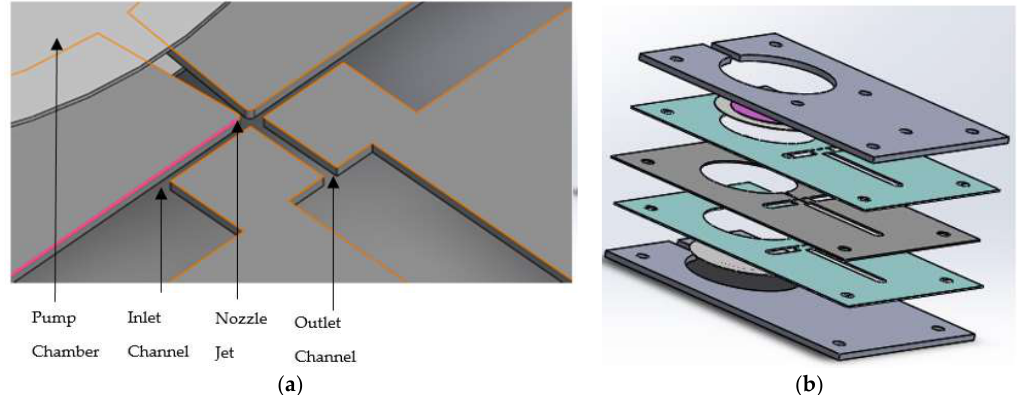
Figure 1. Details of designed model: ( a ) Details of the microfluidic channel; ( b ) Exploded view of the designed model.